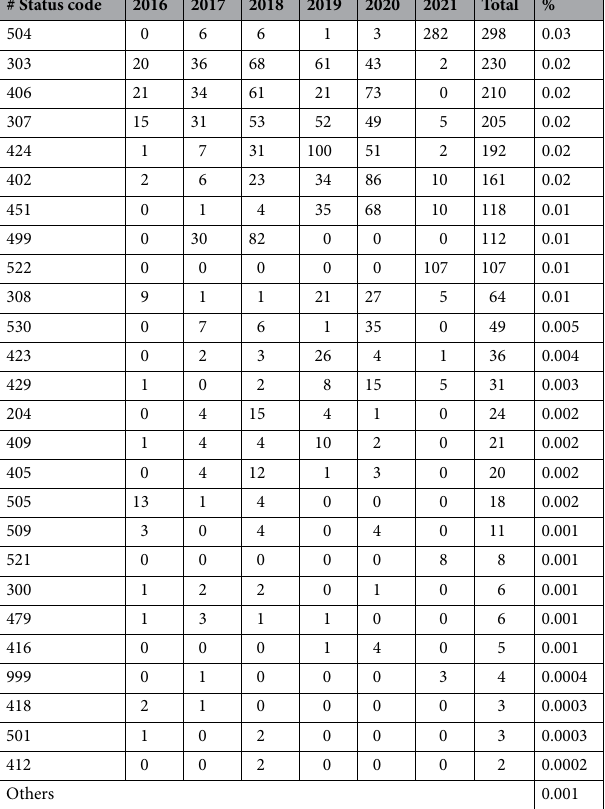
Table 2. Status code occurences #2.